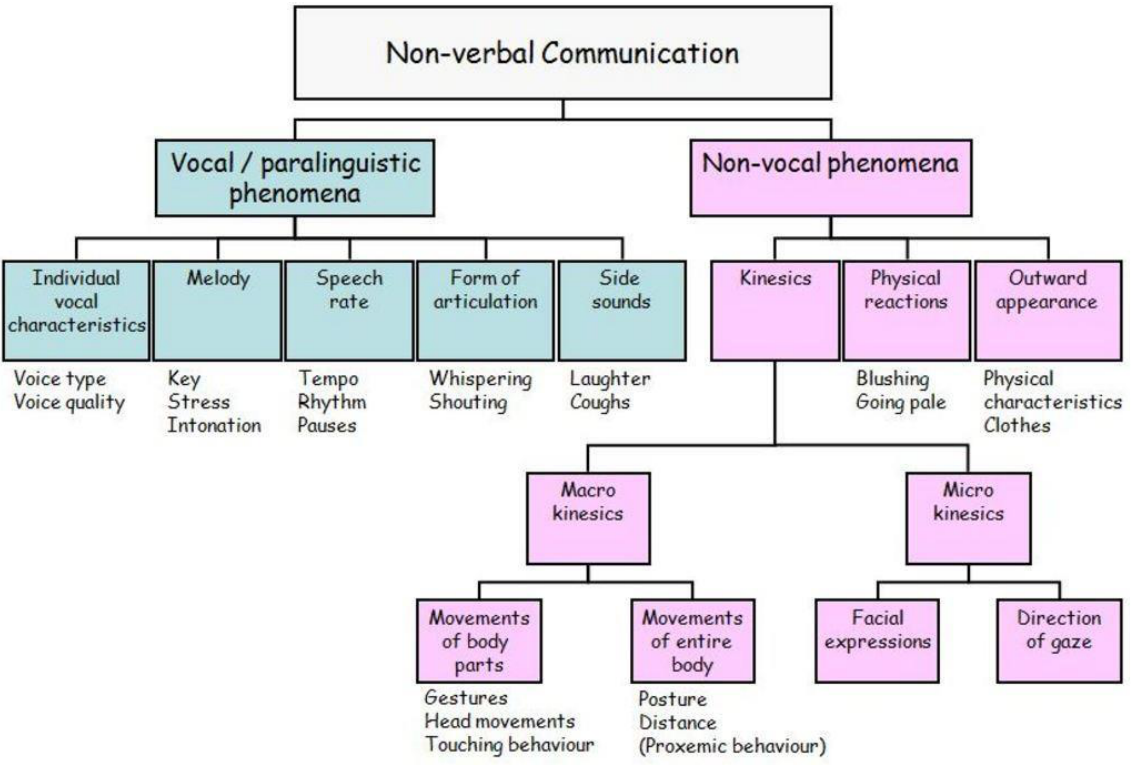
Figure 1. Overview of the main forms of nonverbal communication. The figure has been taken from